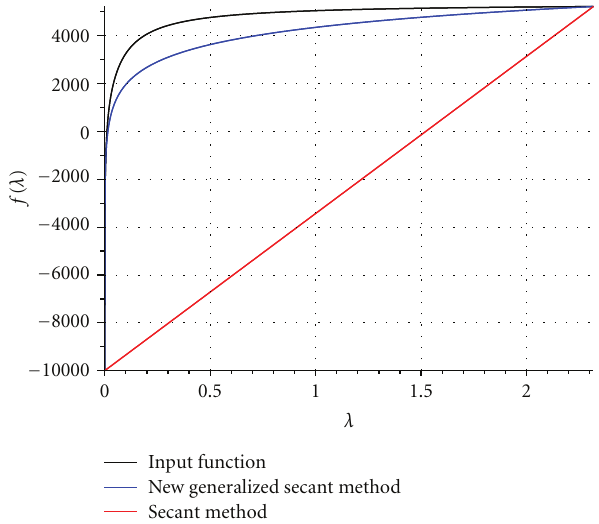
Figure 2: Approximation of the input function f ( λ ) with the generalized secant method and the secant method, n = 1024 and r max =